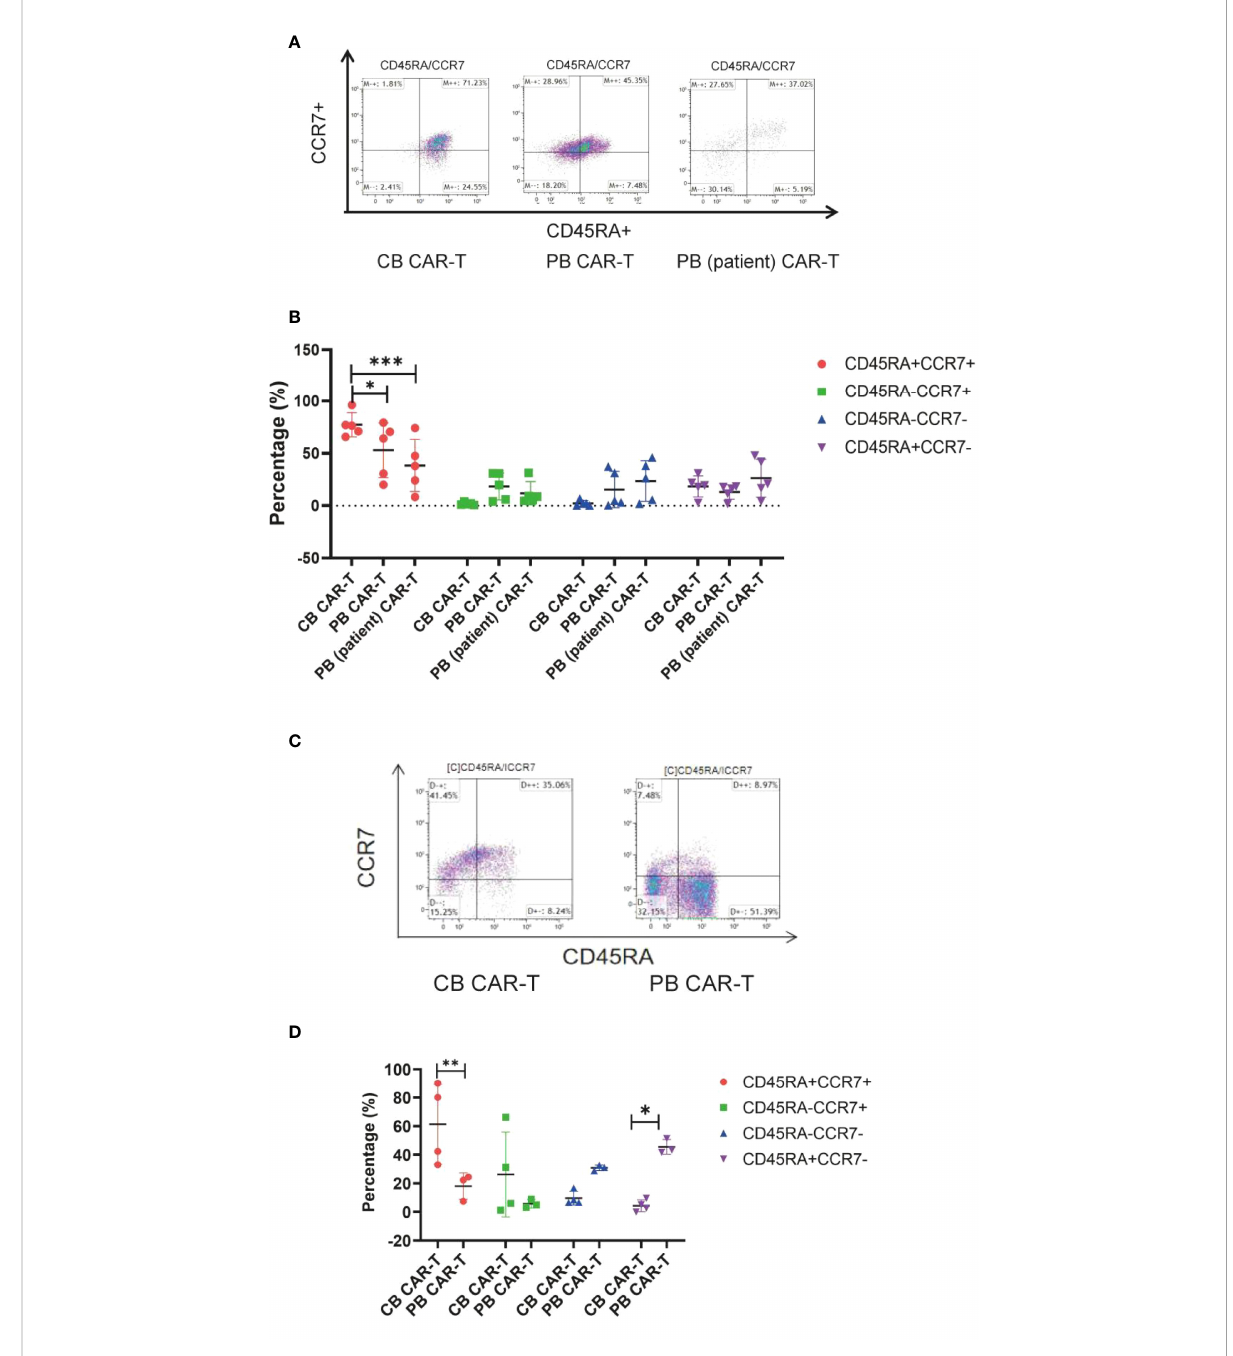
FIGURE 5 Immunophenotype of the three groups of CAR-T cells in vivo . (A) Flow cytometry analysis of TN, TCM, TEM, and TEMRA in the peripheral blood of mice in the three CAR-T groups on day 14. Right upper quadrant: naive T(CD45RA+CCR7+), left upper quadrant: TCM(CD45RA- CCR7+), left lower quadrant: TEM(CD45RA-CCR7-), and right lower quadrant: TEMRA(CD45RA+CCR7-). (B) Proportion of TN, TCM, TEM, and TEMRA in the peripheral blood of mice in the three CAR-T groups on day 14. Red represents TEMRA, green represents TEM, blue represents TCM, and purple represents naive T cells. (C) Flow cytometry analysis of TN, TCM, TEM, and TEMRA in the spleen of mice in the CB and PB CAR-T groups on day 51. (D) Proportion of TN, TCM, TEM, and TEMRA in the spleen of mice in the CB CAR-T and PB CAR-T groups on day 51. TN, Naive T cell; TCM, Central memory T cell; TEM, effector memory T cell; TEMRA, Terminal effector T cell; Treg, regulatory T cell. *p < 0.05, **p < 0.01, ***p <